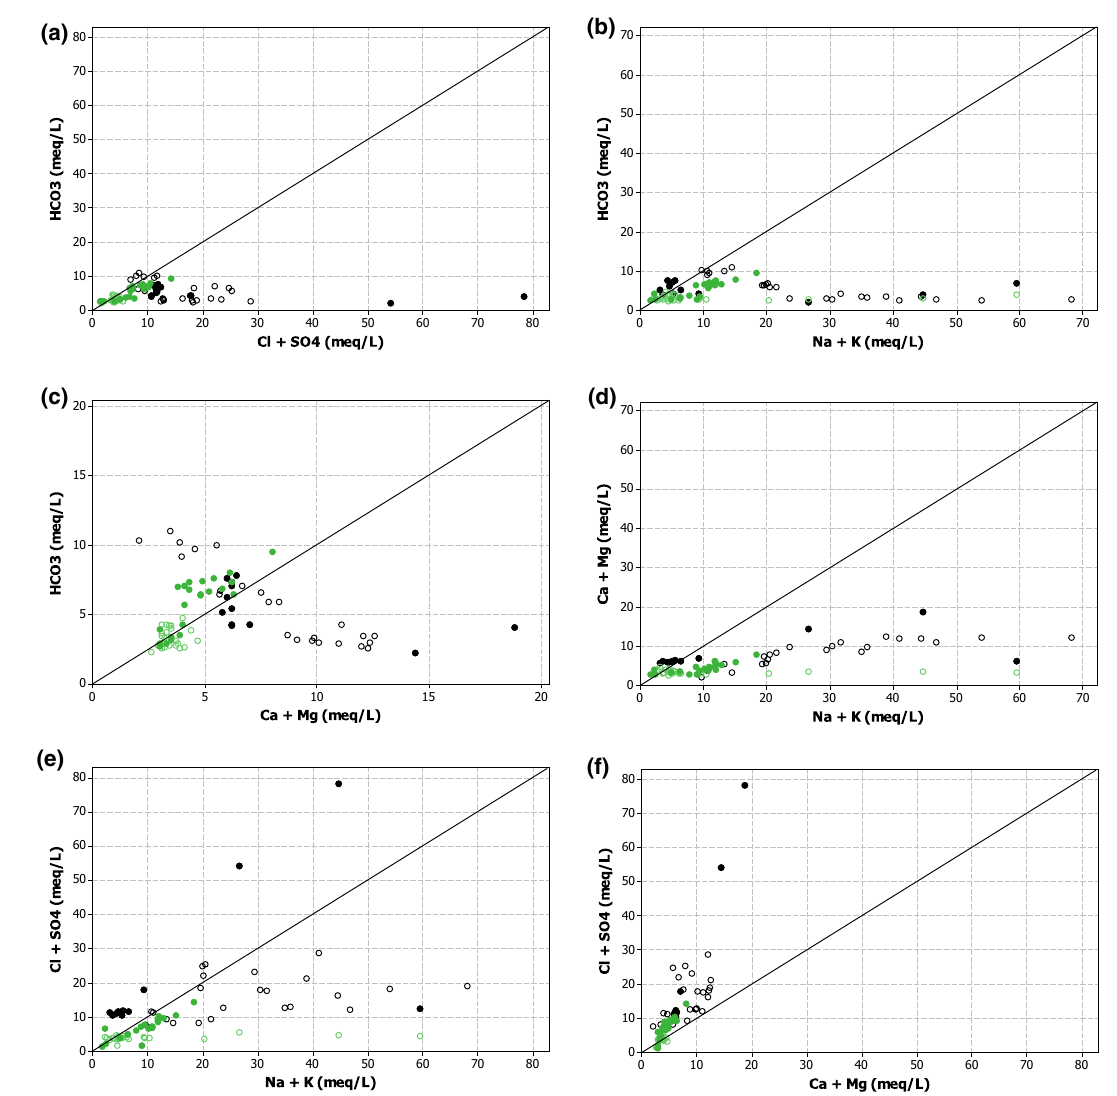
Fig. 5 Proportion of the major ions in the waters of Mayur River. The black blank circles denote pre-monsoon, black filled circles denote mon- soon, green blank circles denote post-monsoon and green filled circles denote winter